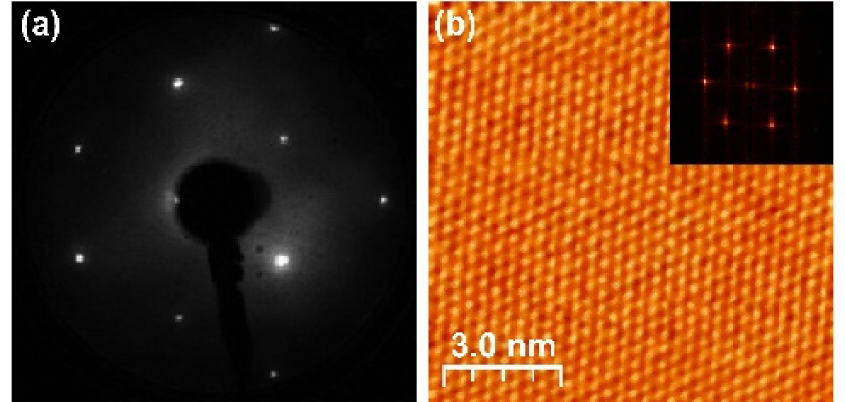
Figure 1. The surface of the Bi 2 Se 3 sample at room temperature. ( a ) LEED pattern at 61 eV, ( b ) 10 × 10 nm STM topography image acquired at V bias = − 430 mV, I = 200 pA. The FFT power spectrum (inset) calculated from the raw STM topography image in ( b